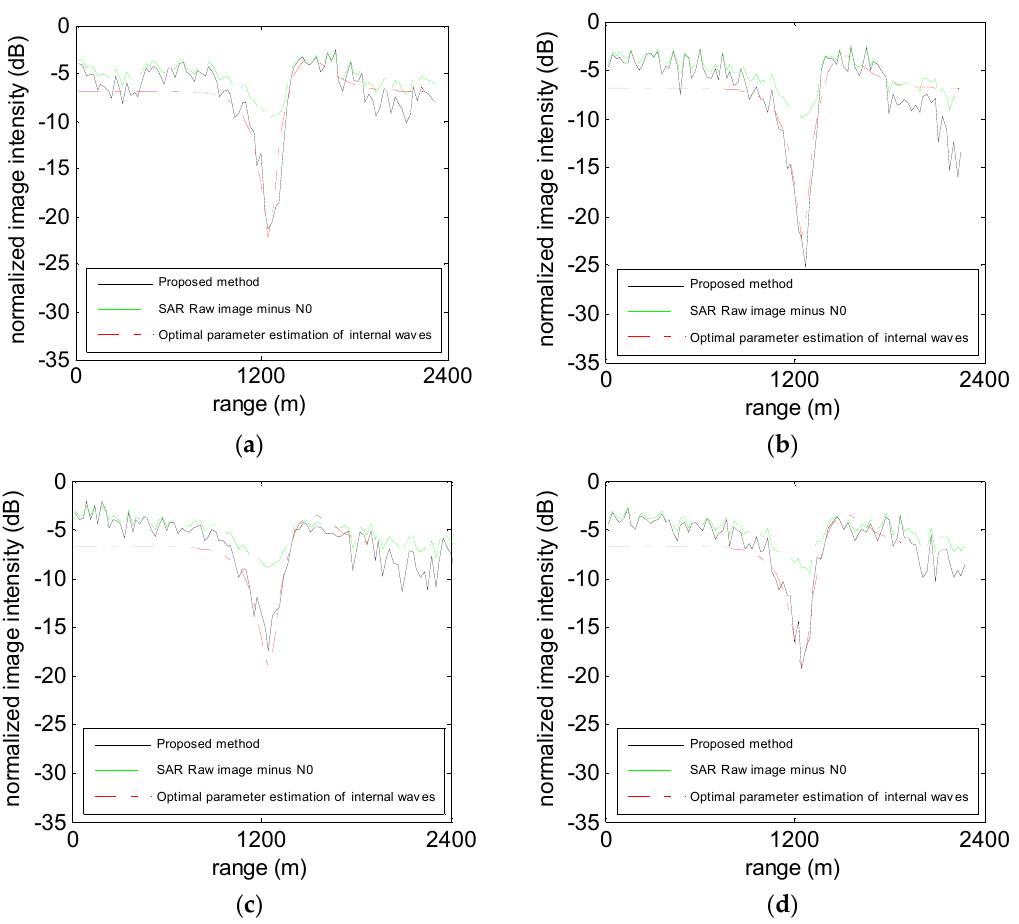
Figure 9. Image intensities along the four white lines in Figure 7. ( a ) the profile a in Figure 7; ( b ) the profile b in Figure 7; ( c ) the profile c in Figure 7; ( d ) the profile d in Figure 7; The green dashed line is the SAR raw image intensity minus N 0 ; the black solid line is the proposed method in this paper; the red dot dash line is the optimal parameter estimation method of internal waves.